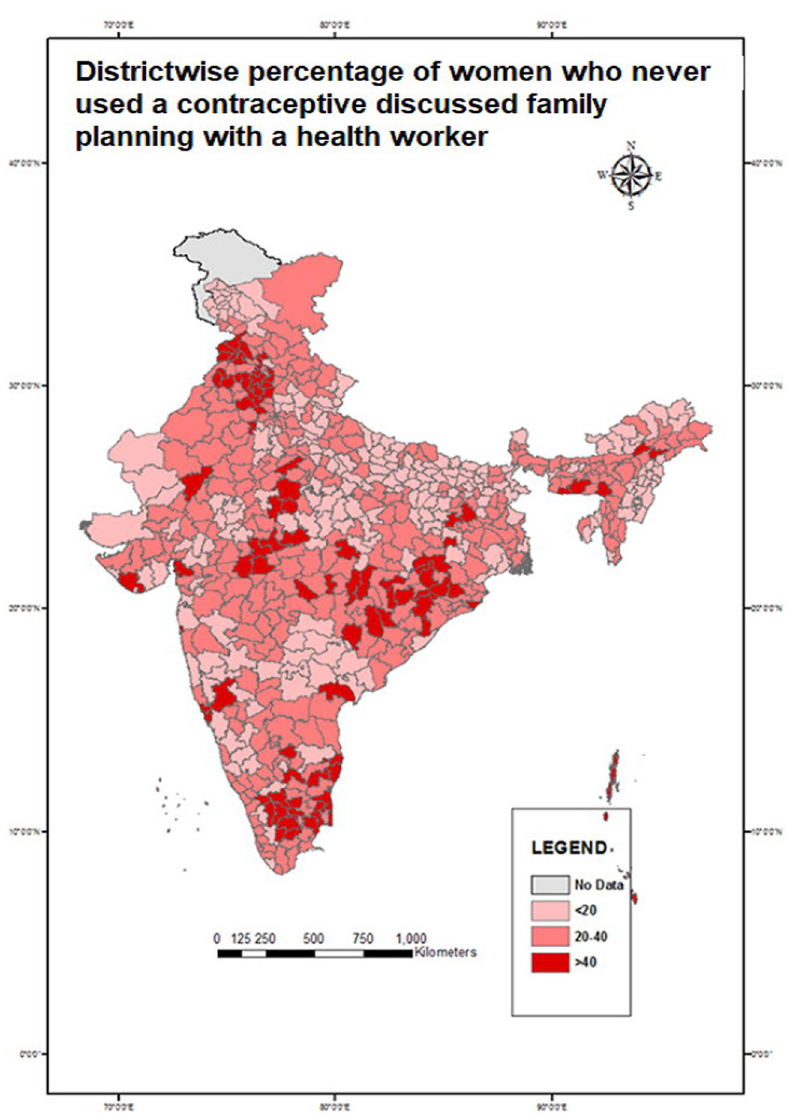
Fig 4. Percentage of married women aged 15–49 years who never used a contraceptive, discussed family planning with a health worker in India, NFHS